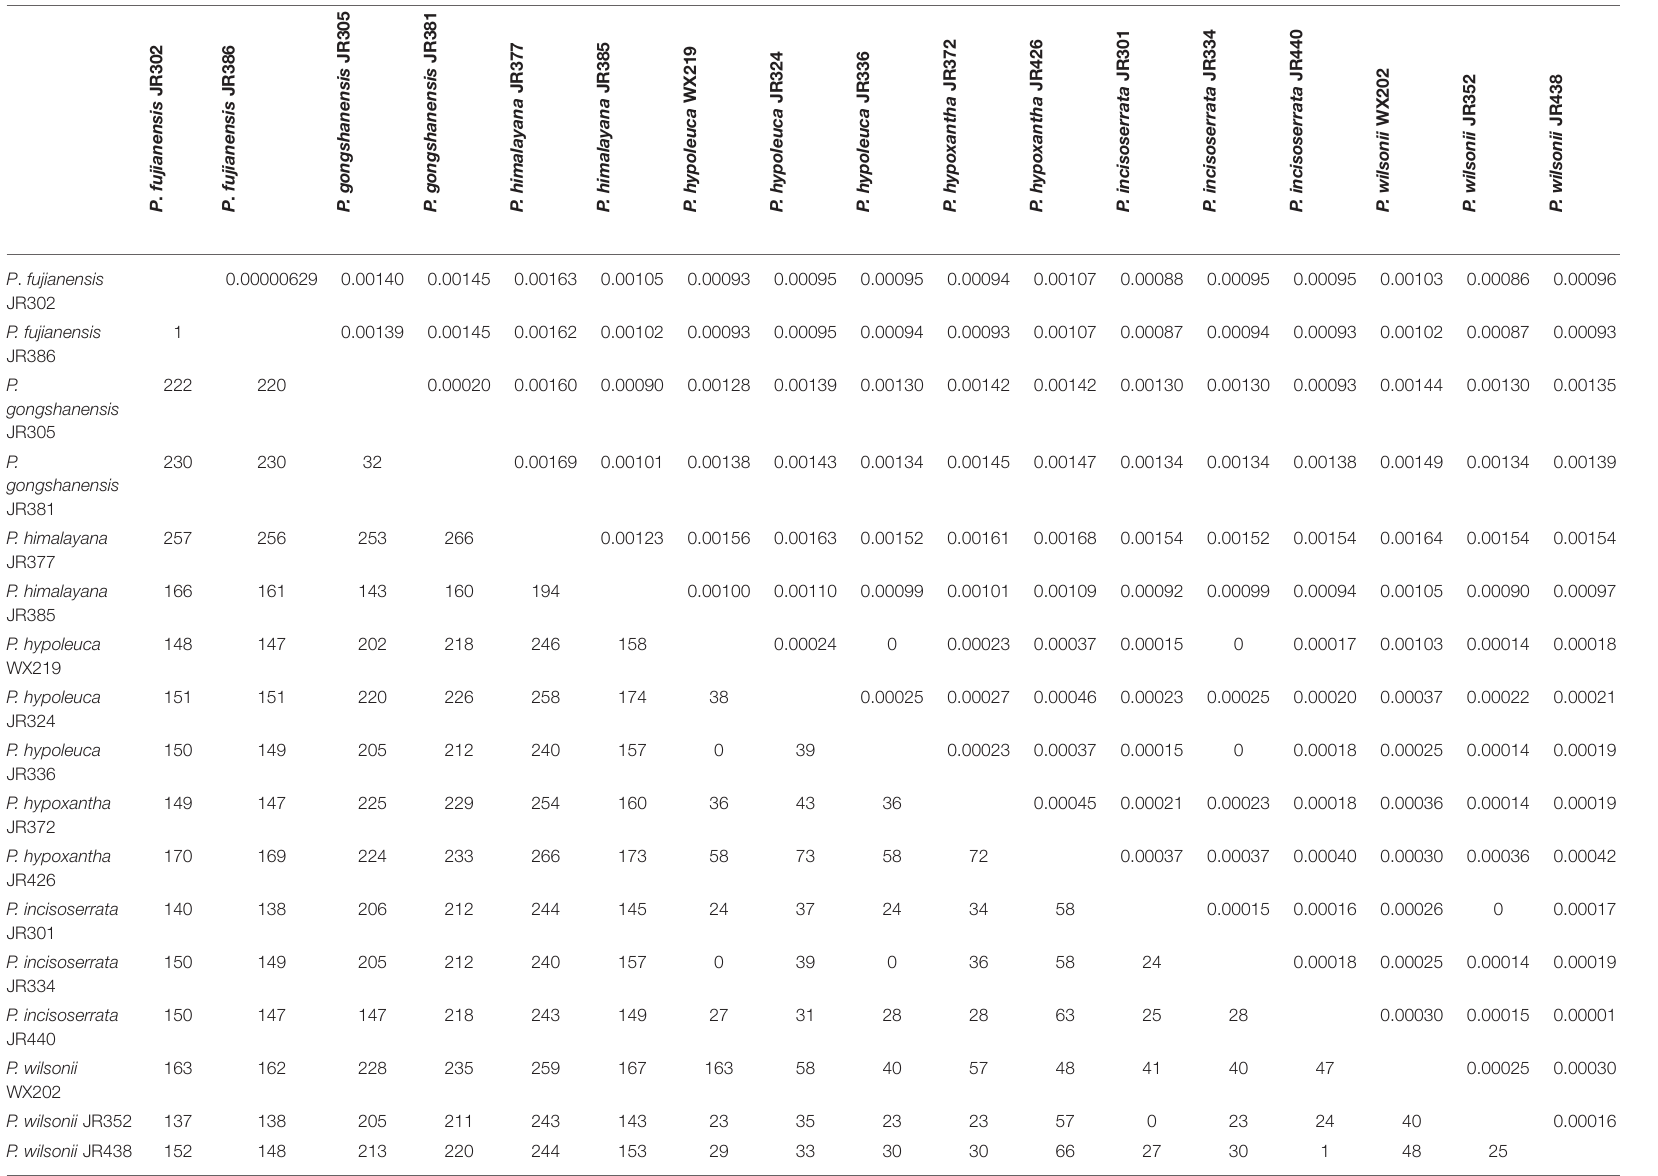
TABLE 3 | Numbers of nucleotide substitutions and sequence distance in Maddenia